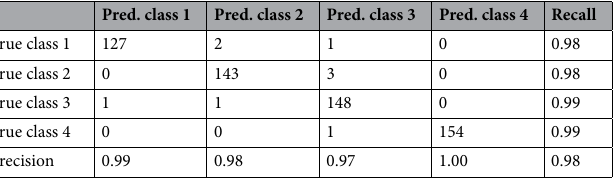
Table 5. Classification model’s performance when features are ABAs and crossing nose displacement.